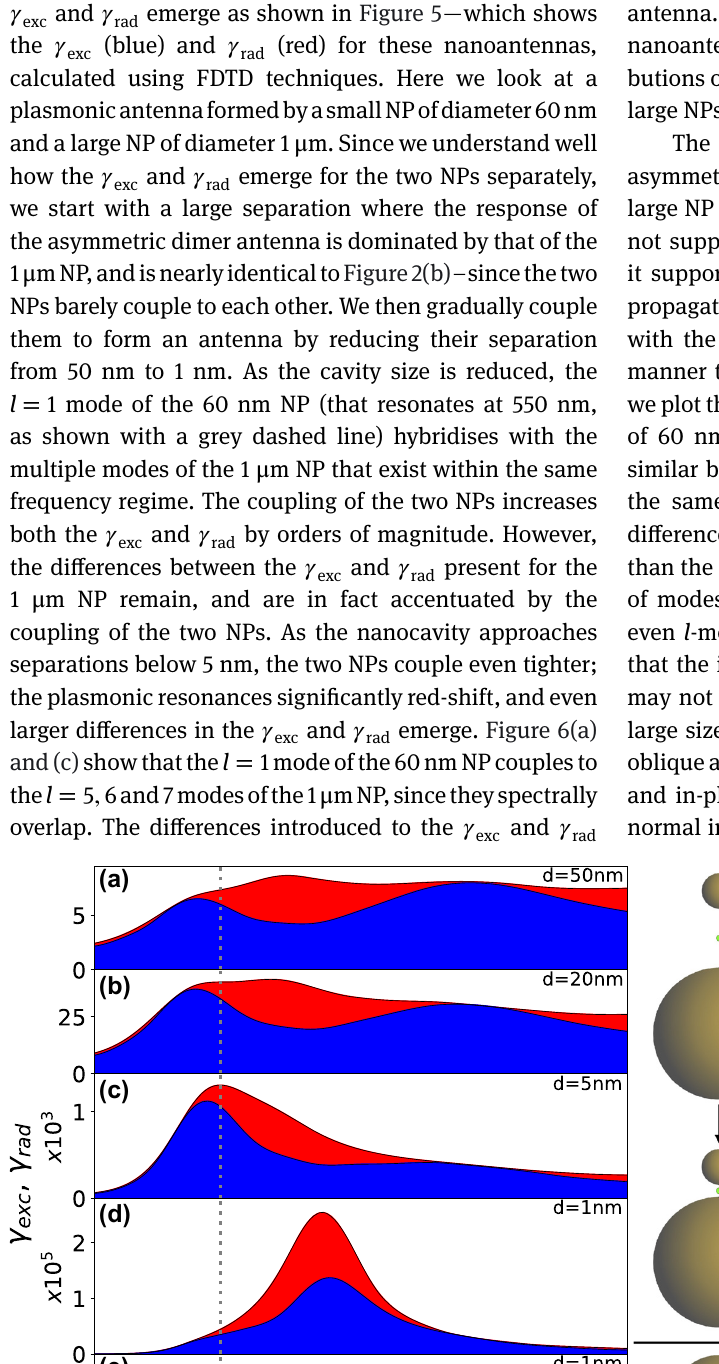
(blue) and 𝛾 (red) calcu- Figure 5: The 𝛾 exc rad latednumericallyfor(a)–(d)asymmetricgold dimer antennas of diameters of 60 nm and 1 μ m, and (e) the NPoM configuration with a gold NP of diameter 60 nm. These have gap sizes of (a) 50 nm, (b) 20 nm, (c) 5 nm, and (d)–(e) 1 nm. The grey dashed line shows the l = 1 resonance of the isolated 60 nm gold NP. The right figure illustrates the closure of the gap, with the green dot indicating the position of the dipole source when , and the location where calculating the 𝛾 rad the fields are measured when calculating the 𝛾 exc